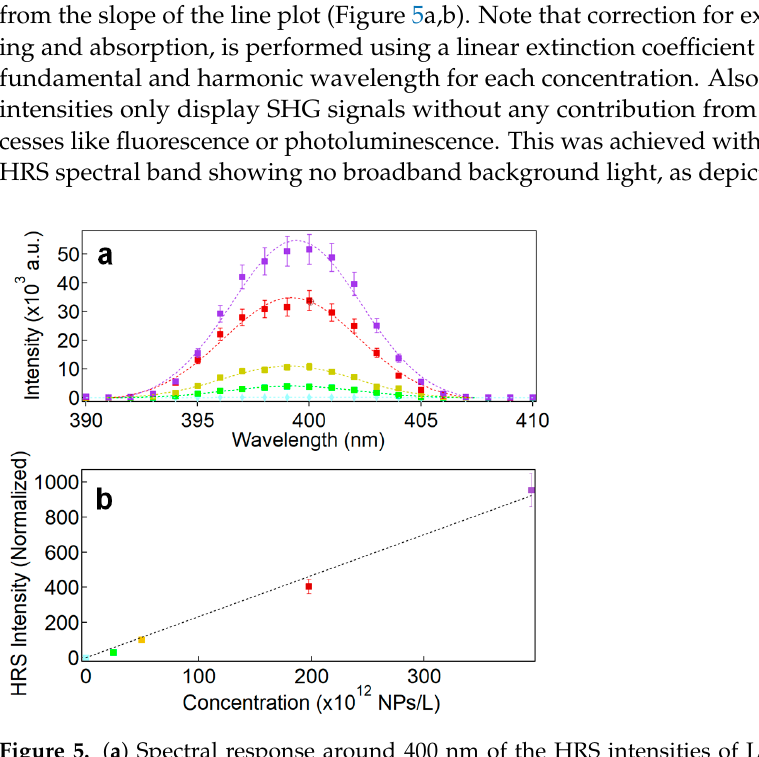
Figure 5. ( a ) Spectral response around 400 nm of the HRS intensities of LN NPs dispersions at different concentrations upon excitation with a vertically polarized wavelength at 800 nm. The corresponding NP concentrations are indicated in the lower panel whereas light blue dots stand for the spectral response of pure water. ( b ) Graphical plot of the normalized HRS intensities as a function of the NP